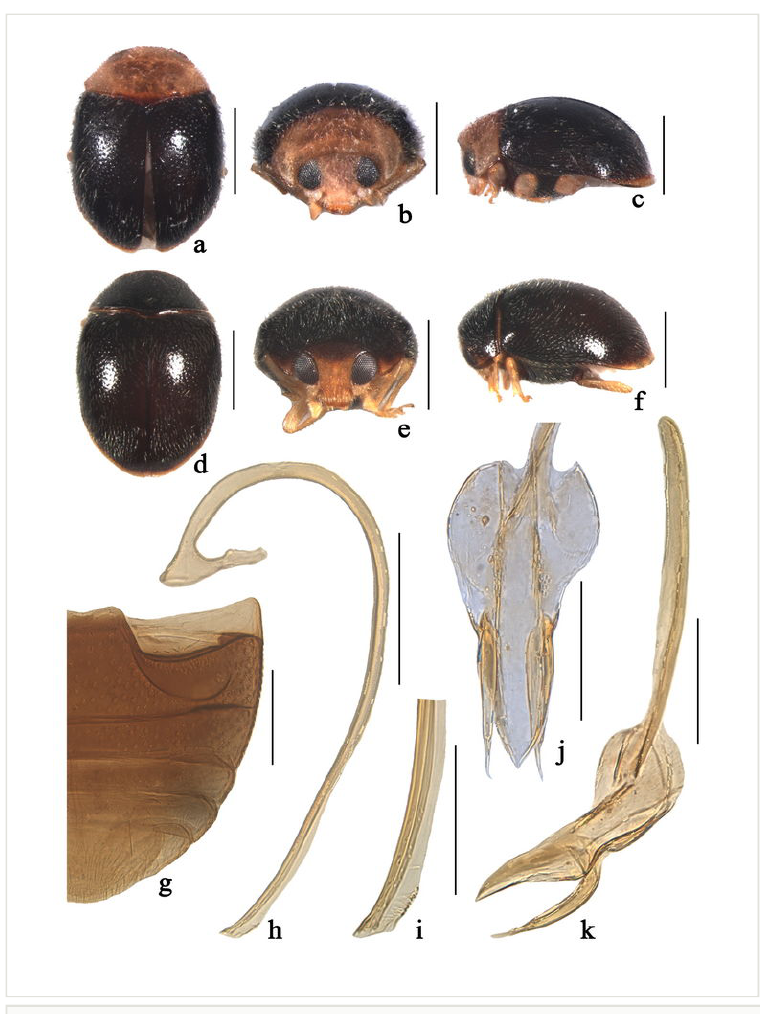
Figure 2. Nephaspis indus Gordon, 1996: (a–c) male; (d–f) female; (a, d) dorsal view; (b, e) frontal view; (c, f) lateral view; (g) abdomen; (h) penis; (i) apex of penis; (j) tegmen, ventral view; (k) tegmen, lateral view. Scale bars: a–f = 0.5 mm, g–h = 0.2 mm, i–k = 0.1